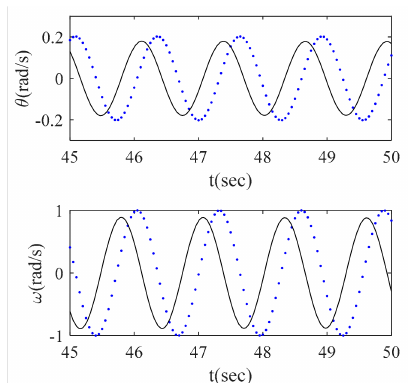
Figure 7. The comparison of the last 5 s.